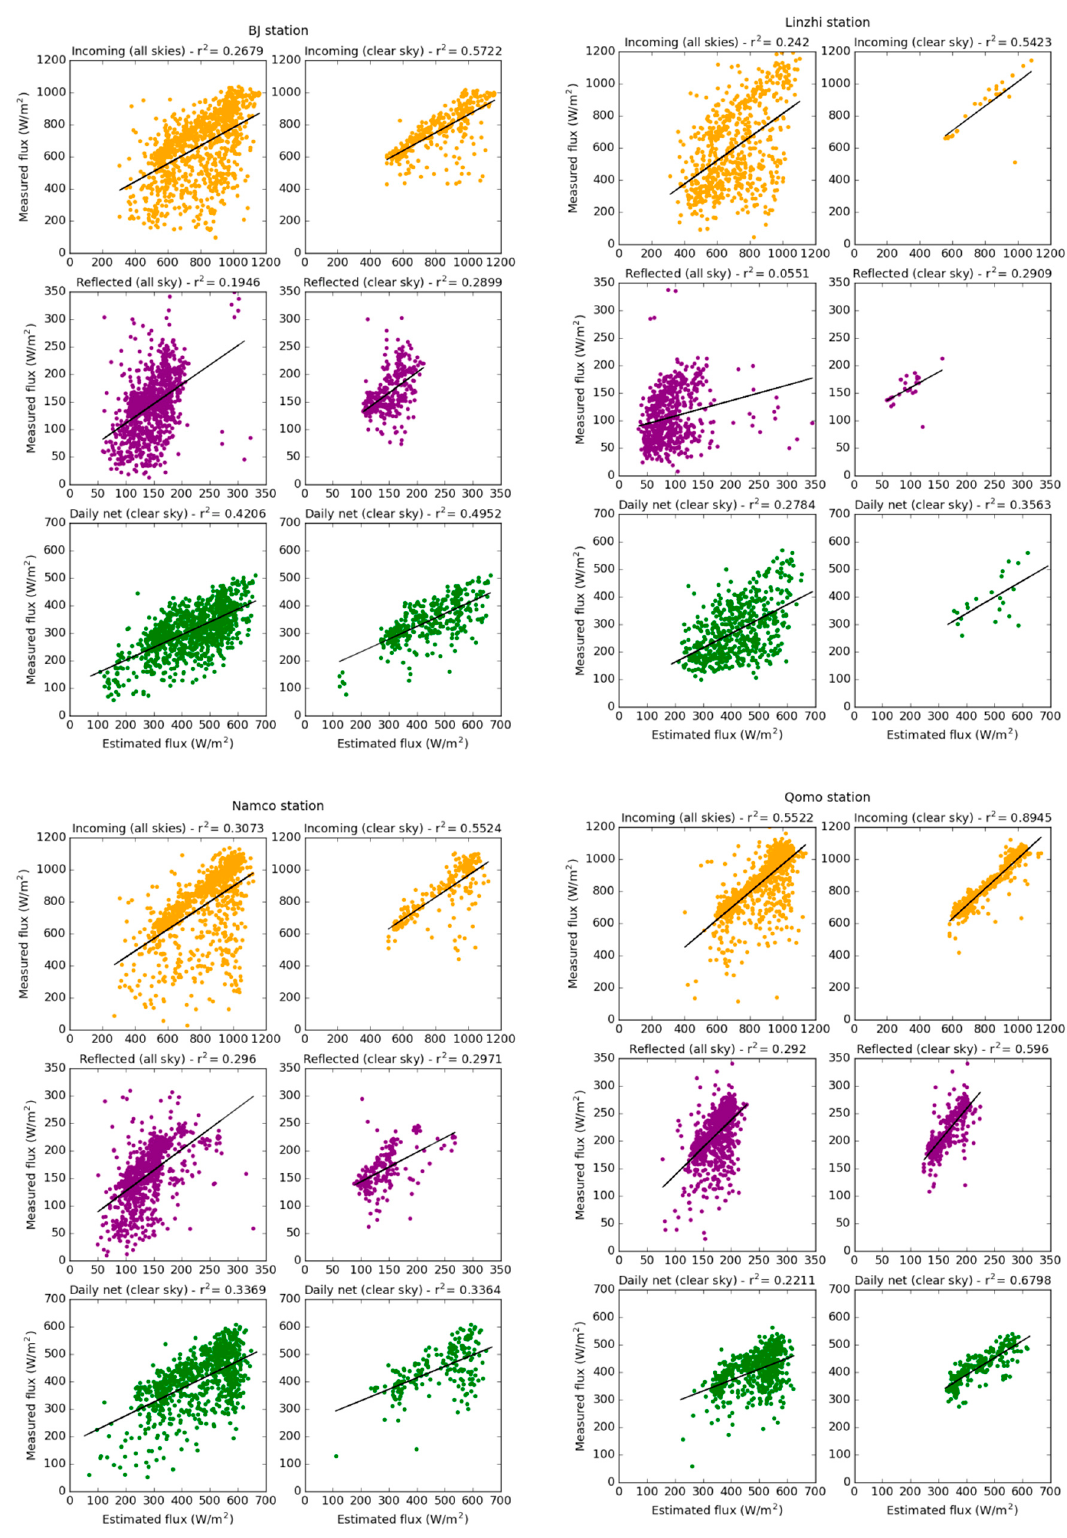
Figure 7. Solar radiative fluxes validation for instantaneous incident (orange) and reflected (purple) fluxes as well as daily net solar radiation (green). The validation is provided for all skies ( left ) or clear sky ( right ) conditions, at BJ, Qomo, Linzhi, and NamCo stations for the entire time series. According to Figure 7, better results are obtained when the solar radiative fluxes are estimated for clear sky, especially the instantaneous irradiance. The estimation of the latter performs also better